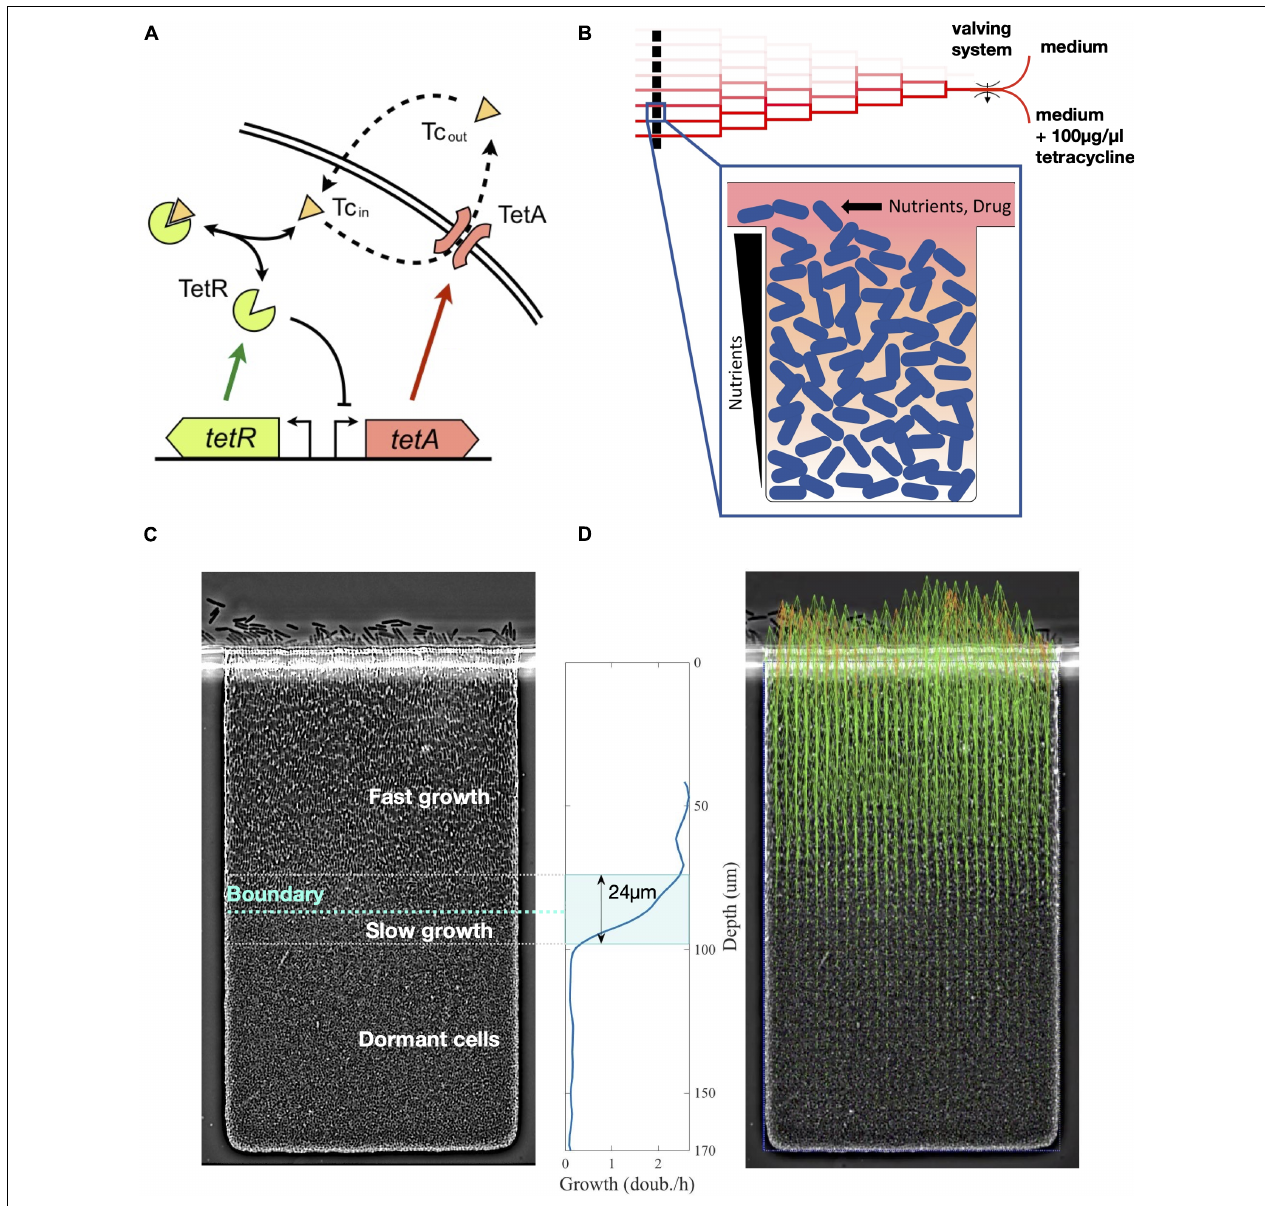
FIGURE 1 | Nutrient depletion in microcolonies creates a boundary between fast-growing and arrested cells. (A) tet resistance mechanism: tetracycline (Tc), a translation inhibitor, diffuses across the cell membrane and binds transcription repressor TetR, which becomes inactive and releases expression of both TetR and TetA. Efflux pump TetA exports tetracycline out of the cell in an ion exchange. (B) Schematic of our microfluidic device. Media supply channels deliver nutrients to one edge of microcolonies. Nutrients diffuse down the trap and are actively consumed, thereby creating a gradient toward the interior of the colony. A linear mixer creates 8 different drug concentrations, which are quickly delivered to cell traps through the supply channels. (C) Steady state of an E. coli colony in the absence of drugs. Nutrient depletion creates a relatively sharp boundary that divides growing cells closer to the surface of the colony and dormant cells in the interior of the trap. Around the boundary there is a transition zone of slow growth. (D) Cell growth in the lower layers of the trap pushes cells toward the surface of the colony. We obtain the velocities of this movement at each point in the trap from time-lapse microscopy images using particle image velocimetry (PIV). Green arrows represent velocity measurements, outliers are replaced by extrapolated values (orange arrows). We then calculate cell growth by differentiating vertical velocities with respect to depth. The transition zone of 24 µ m going from 90 to 10% of maximum growth is